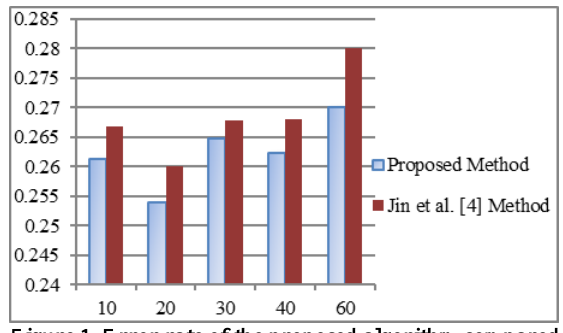
Figure 1. Error rate of the proposed algorithm compared with algorithm of Jin et al .